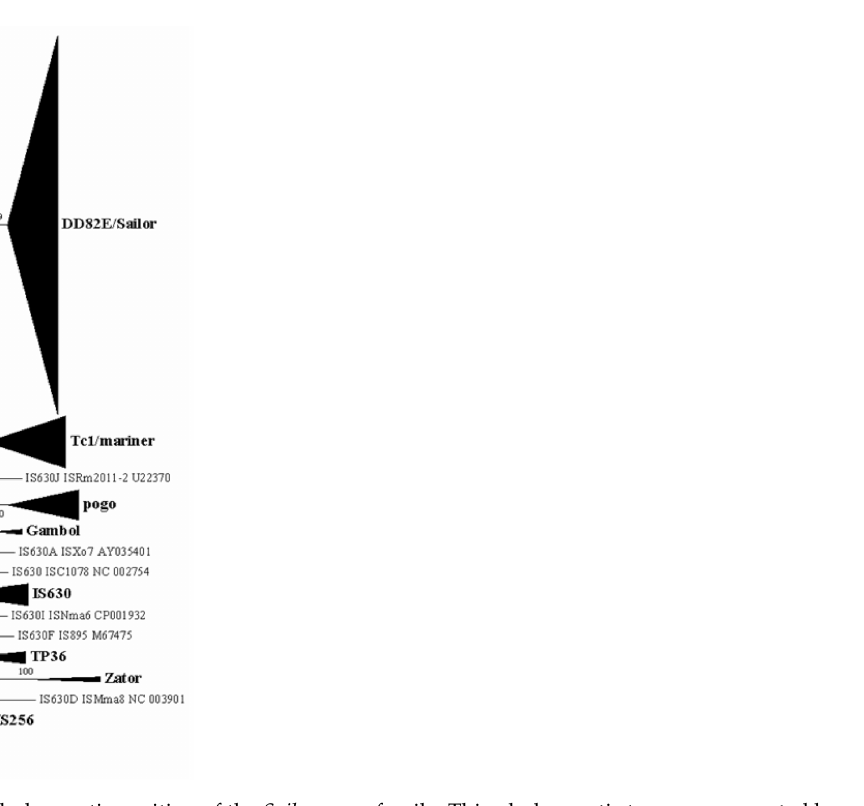
Figure 2. Phylogenetic position of the Sailor superfamily. This phylogenetic tree was generated based on DDE domains using the maximum likelihood method in the IQ-TREE program with an ultrafast bootstrap approach (1000 replicates). The reference families and elements included DD34E/ Tc1 , DD34E/ Gambol , DD35E/ TR , DD36E/ IC , DD37E/ TRT , DD38E/ IT , DD34D/ mariner , DD37D/ maT , DD39D/ GT , DD41D/ VS , DDxD/ pogo , IS630 transposases, TP36 , and Zator . IS256 was used as an outgroup. The uncollapsed tree is presented in Figure